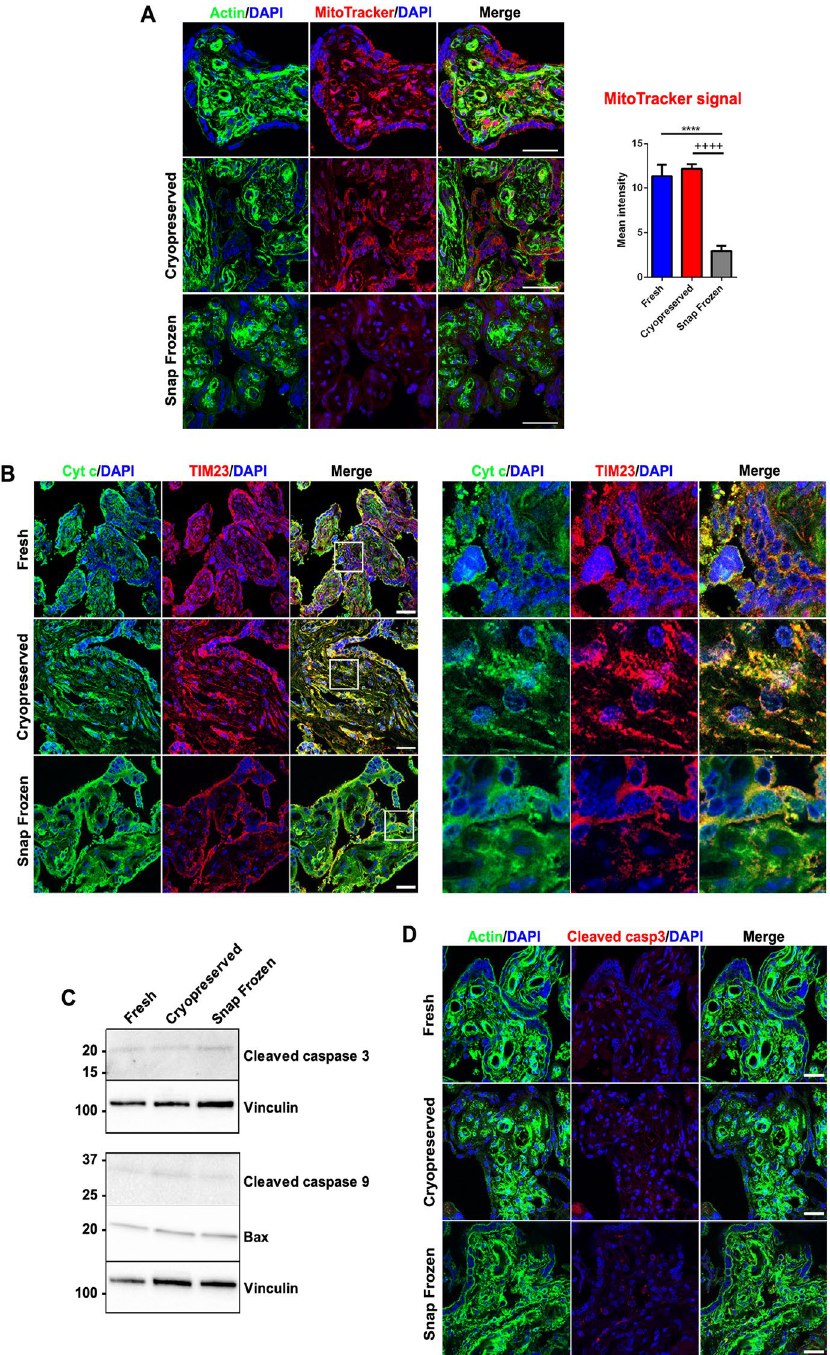
Fig. 3 Mitochondrial membrane potential and apoptotic activation after placental biopsies cryopreservation and snap freezing. A Confocal fluorescence images of placental sections stained with actin (green), MitoTracker (red), and DAPI (blue). Mitochondrial membrane potential quantifications in fresh, cryopreserved, and snap frozen conditions are provided (right graph). Scale bar: 50 μm. *versus fresh saponin placental specimens [****p < 0.0001]; versus cryopreserved placental specimens [ p < 0.0001]. Values are expressed as mean SEM. B Left panel + + + + + ± images: confocal immunofluorescences of placental sections stained for cyt c (green), TIM23 (red), and DAPI (blue). Scale bar: 50 μm. Right panel images: magnifications of left panel’s inserts showing cyt c/TIM23 colocalization. C Representative immunoblotting analysis of cleaved caspase 3 (upper panel), cleaved caspase 9, Bax (lower panel), and vinculin as loading control in fresh, cryopreserved, and snap frozen placental protein extracts. D Confocal immunofluorescences of placental sections stained for actin (green), cleaved caspase 3 (red), and DAPI (blue). Scale bar: 50